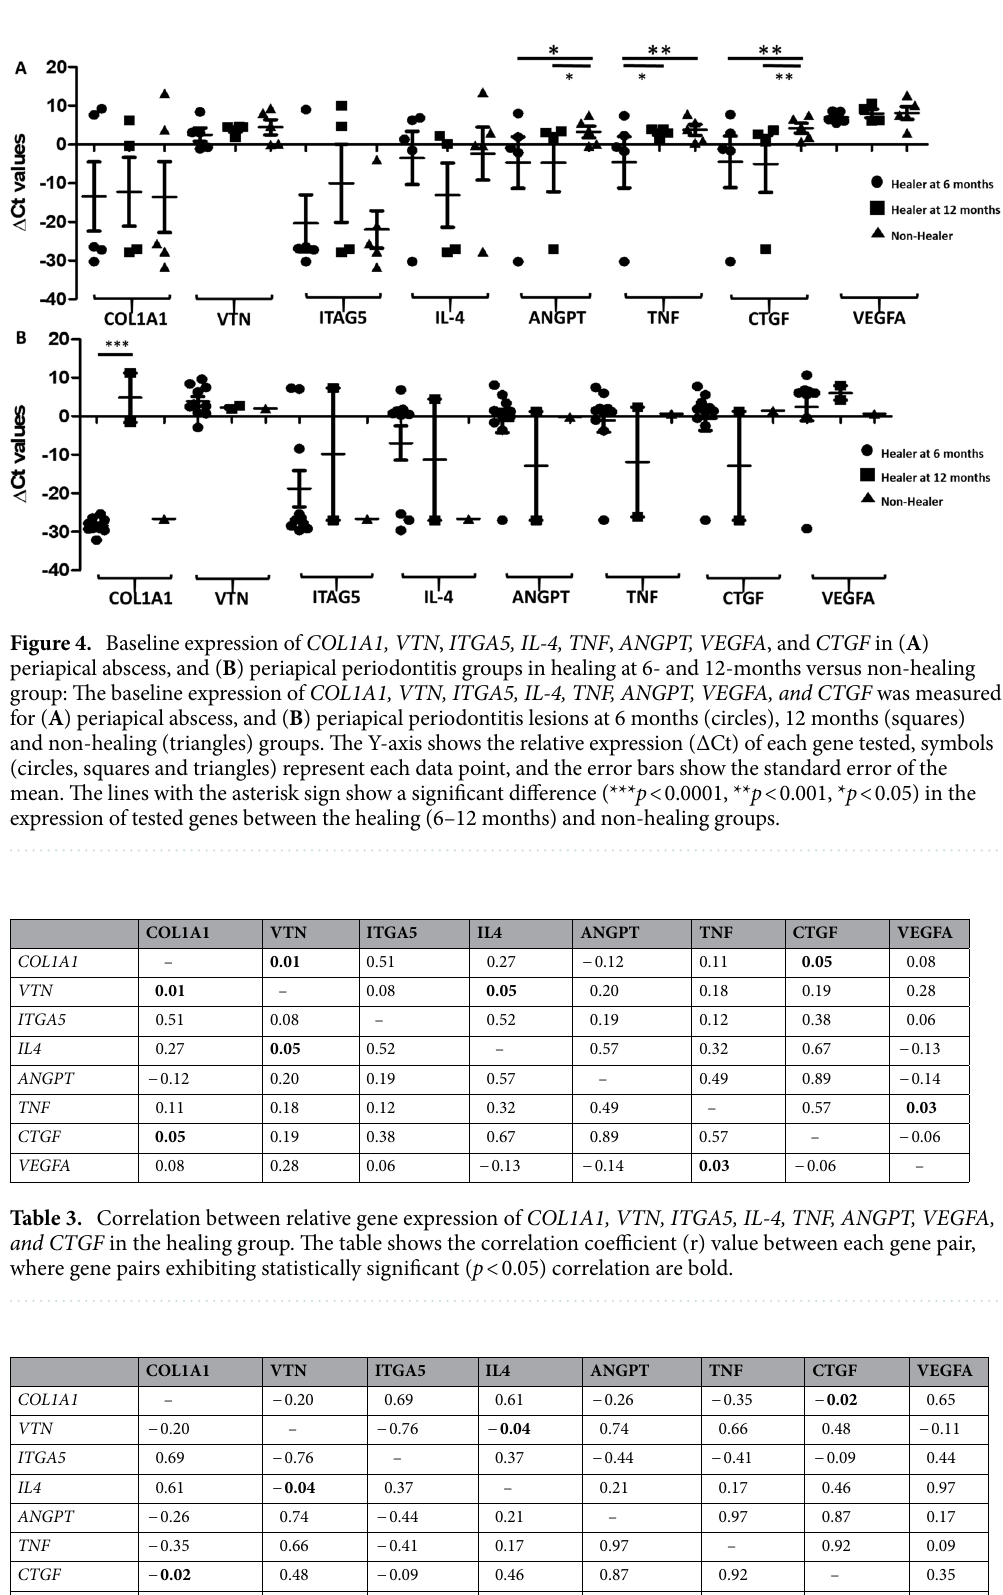
Table 4. Correlation between relative gene expression of COL1A1, VTN, ITGA5, IL-4, TNF, ANGPT, VEGFA, and CTGF in the non-healing group. The table shows the correlation coefficient (r) value between each gene pair, where gene pairs exhibiting statistically significant ( p < 0.05) correlation are bold.